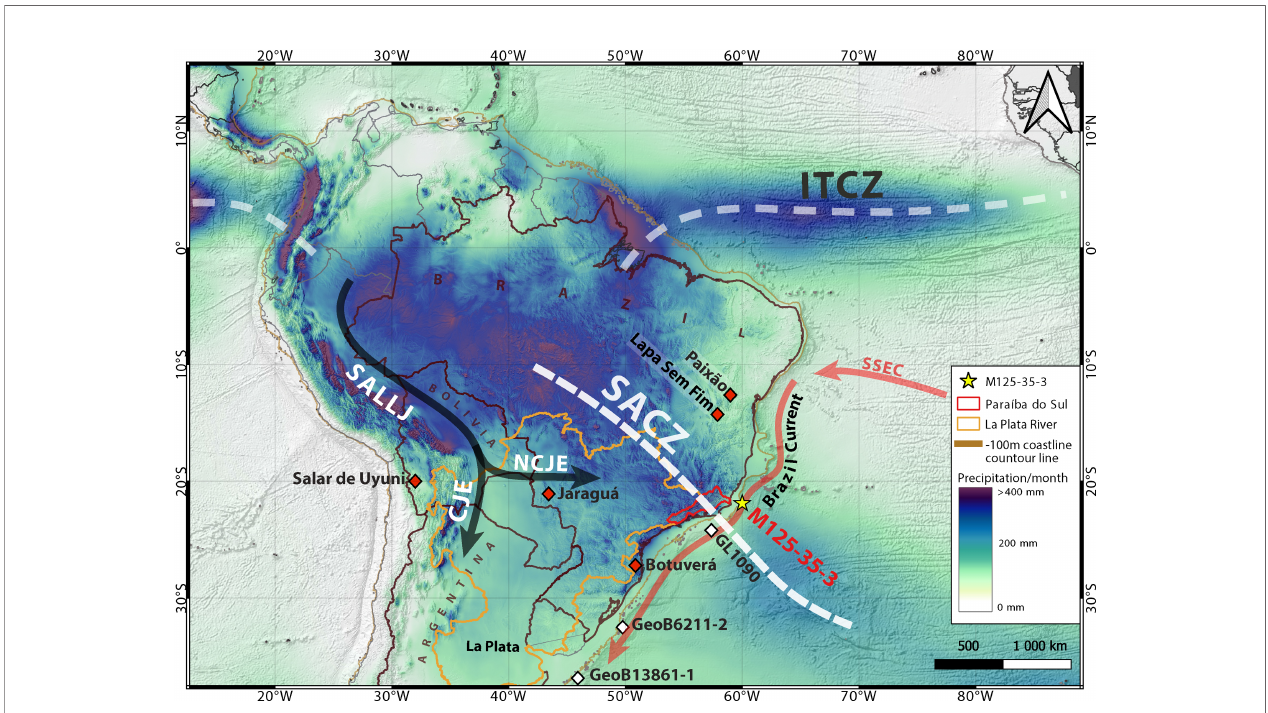
FIGURE 1 | Map of monthly average austral summer precipitation (December-February) across (sub)tropical South America (Karger et al., 2021). The precipitation pattern illustrates a fully established South American Monsoonal System. Note enhanced precipitation along the South Atlantic Convergence Zone (SACZ) indicated by NW-SE oriented white dashed line. The yellow asterisk marks Core M125-35-3 (this study). White diamonds indicate marine sedimentary climate archives mentioned in the text. Red diamonds re fl ect terrestrial paleo-rainfall reconstructions mentioned in the text. Black arrows indicate the South American Low Level Jet (SALLJ) in two different modes: the southward oriented Chaco Jet Event (CJE) and the eastward oriented No Chaco Jet Event (NCJE). The red and orange outlines indicate the drainage basins of the Para ı ́ ba do Sul located in the core region of the SACZ and the La Plata River. Countries mentioned in the main text (i.e. Brazil, Bolivia and Argentina) were outlined. The thick orange arrows represent major oceanic surface currents in the western sub(tropical) South Atlantic, namely the southward fl owing Brazil Current which is fed by the southern South Equatorial Current (SSEC). ITCZ, Intertropical Convergence